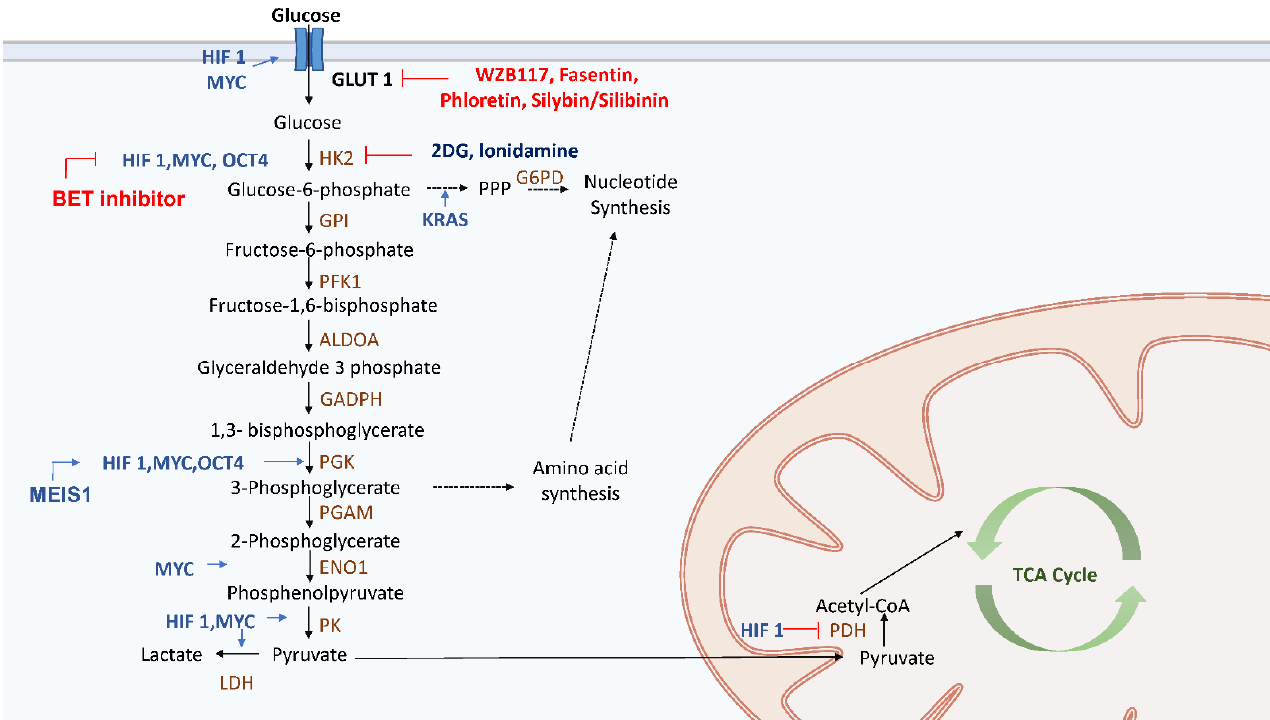
Figure 2. Glycolytic pathway and targets of anticancer drugs in CSCs. Glucose is first imported into CSCs through a glucose transporter (GLUT) and then metabolized by multiple glycolytic enzymes to generate ATP. Besides, glycolysis also provides precursors for biosynthesis of amino acids and nucleotides. Several factors, such as hypoxia-inducible factor (HIF), MYC, OCT4, MEIS1 affect the flux of the glycolytic pathway. HIF promotes glycolysis by upregulation of GLUT and glycolytic enzymes, which are also targets of some anticancer drugs, such as WZB117, fasentin, phlorstin, silybin/silibinin, 2-deoxyglucose (2-DG), ionidamine, and the BET inhibitor.